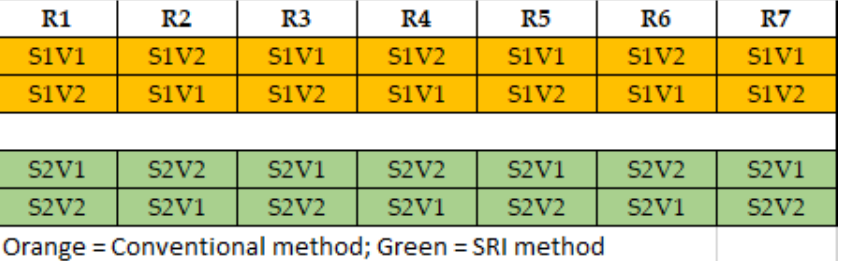
Figure 1. Experimental layout at each location. R—Replication; S1—system 1 (normal system of cultivation); S2—system 2. (System of Rice Intensification); V1—hybrid; V2—high-yielding improved inbred variety.